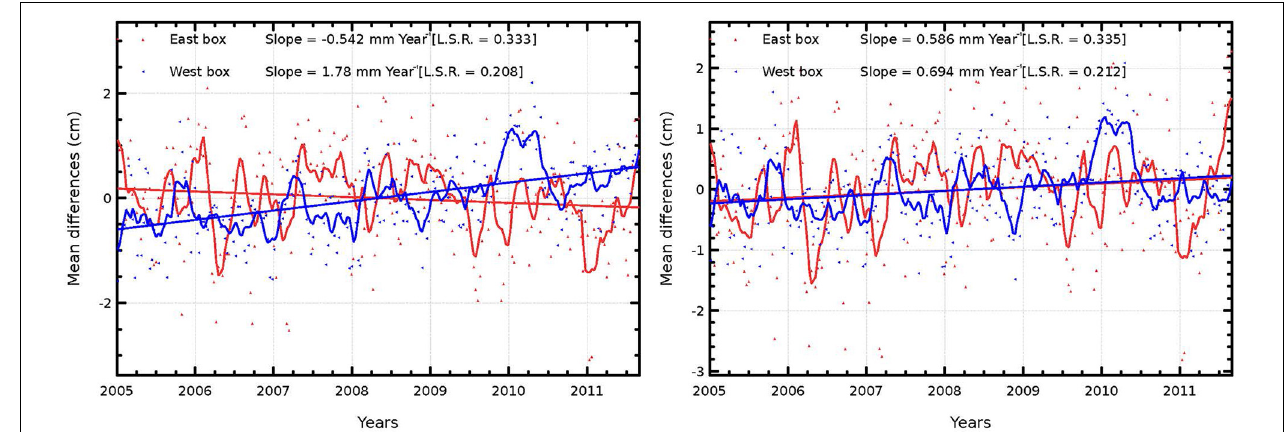
FIGURE 2 | Sea Surface heights differences (cm) between Jason-1 altimeter data (cycles 1–355) and dynamic height anomalies derived from the Argo in situ measurements (referenced to 900 dbar) computed with GDR-D (left) and GDR-E orbit solution (right), separating east box (Long: 60 ◦ /120 ◦ , Lat: –30 ◦ /30 ◦ , in red) and west box (Long: –150 ◦ /–190 ◦ , Lat: –50 ◦ /10 ◦ , in blue). Corresponding annual and semi-annual signals are removed. Trends of raw data (dots) are indicated, and the 2-month filtered signal is added (curves). The hemispheric trend bias is reduced from 2.32 to 0.1 mm/yr. Adapted from Legeais et al.